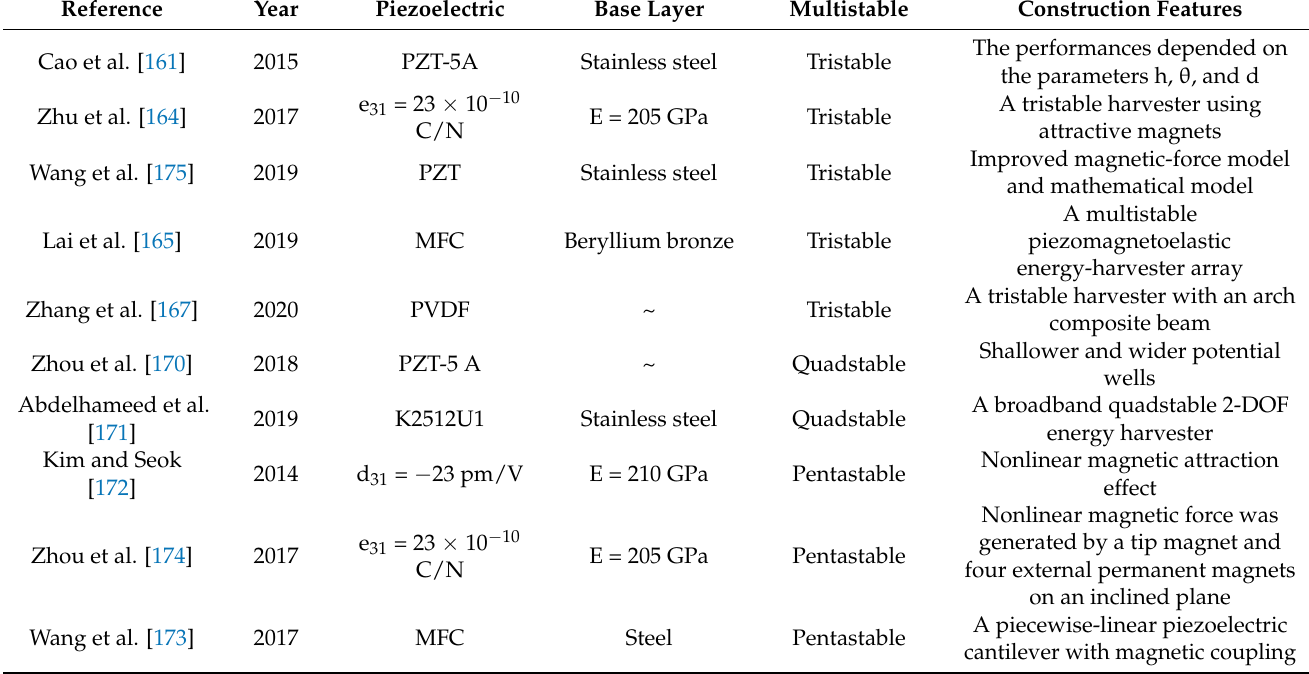
Table 3. Characteristics of some existing multistable-type piezoelectric